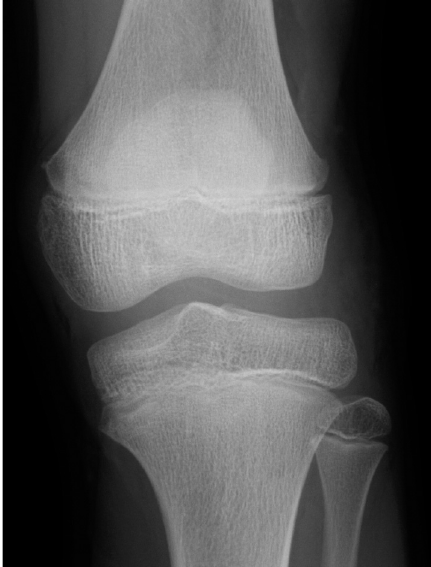
Figure 1. Plain radiographs of the knee joint did not show calcified and osseous lesions.